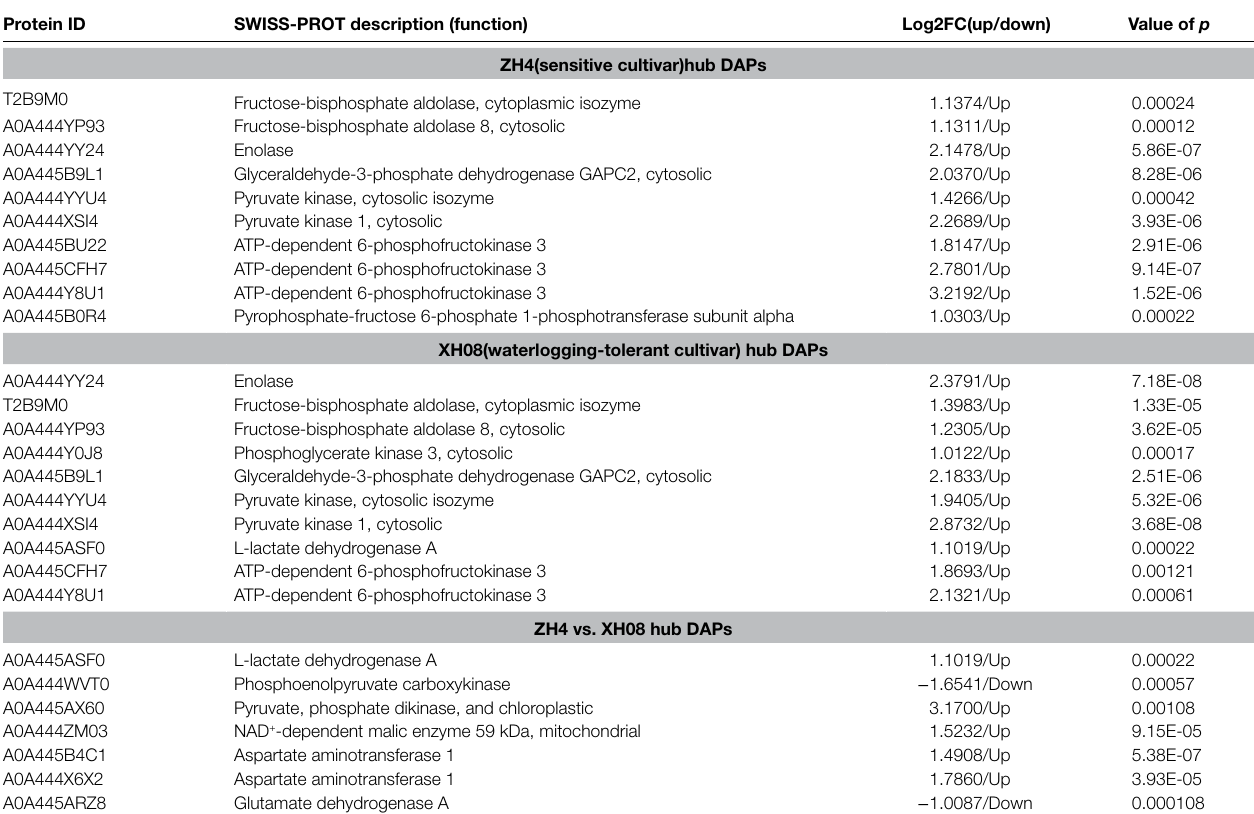
TABLE 1 | The hub DAPs (confidence score ≥ 500) in the interaction network between XH08, ZH4, and their control groups. Protein ID SWISS-PROT description (function) Log2FC(up/down) Value of